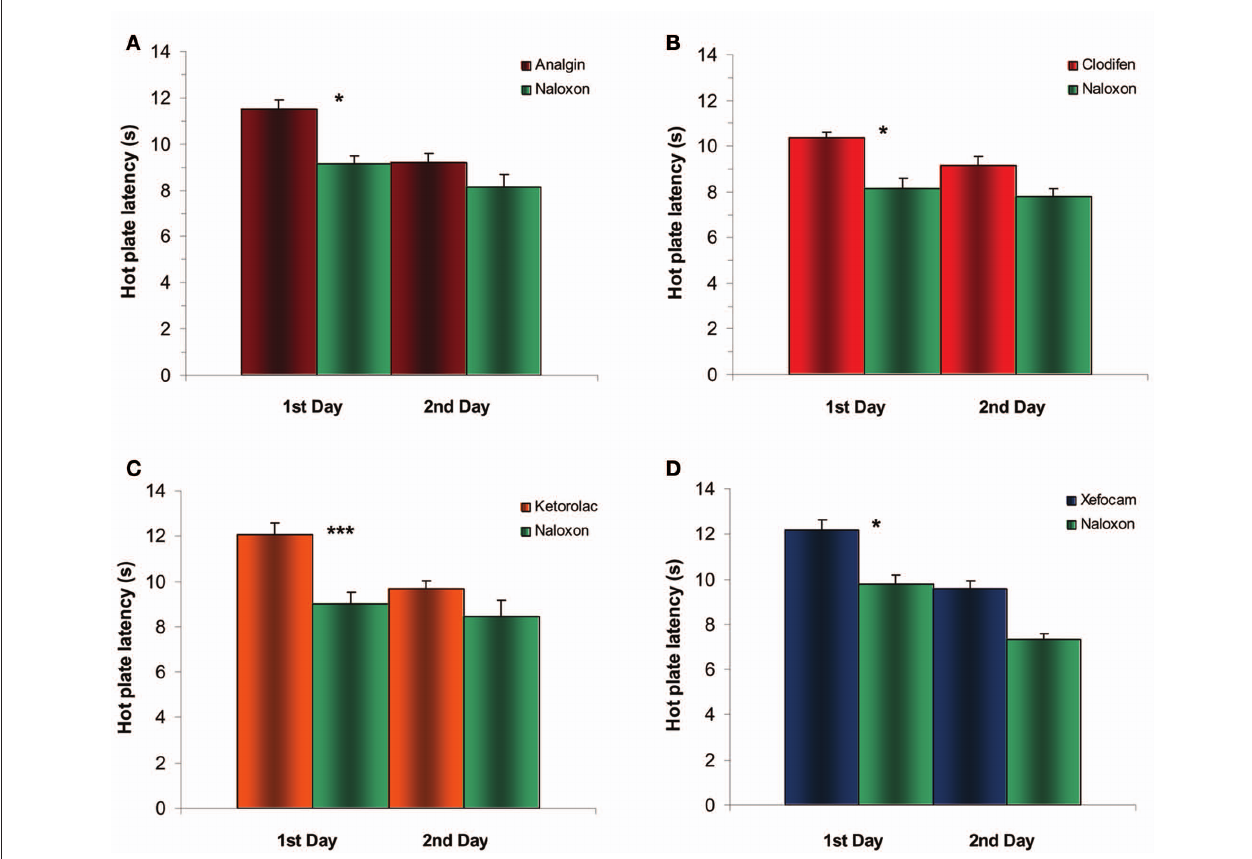
Figure 5 | experiments of post treatment with naloxone after microinjection of NSAiDs into NrM results in a significant decrease in HP latency for the first day for analgin (A), clodifen (B), ketorolac (C), and xefocam (D), respectively. On the second day, there are trend effects for all four non-opioid analgesics. N =4 per